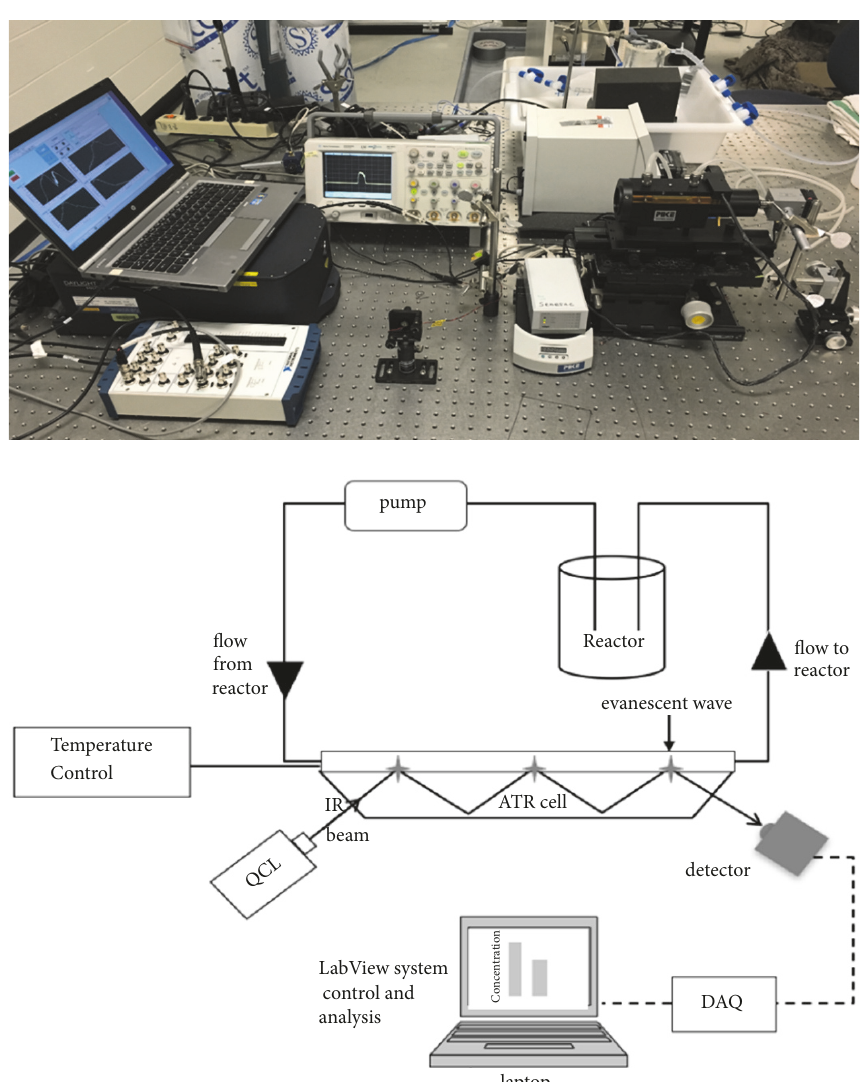
Figure 1: (a) Picture of the ATR-QCL laboratory set up and (b) Schematic of the ATR-QCL